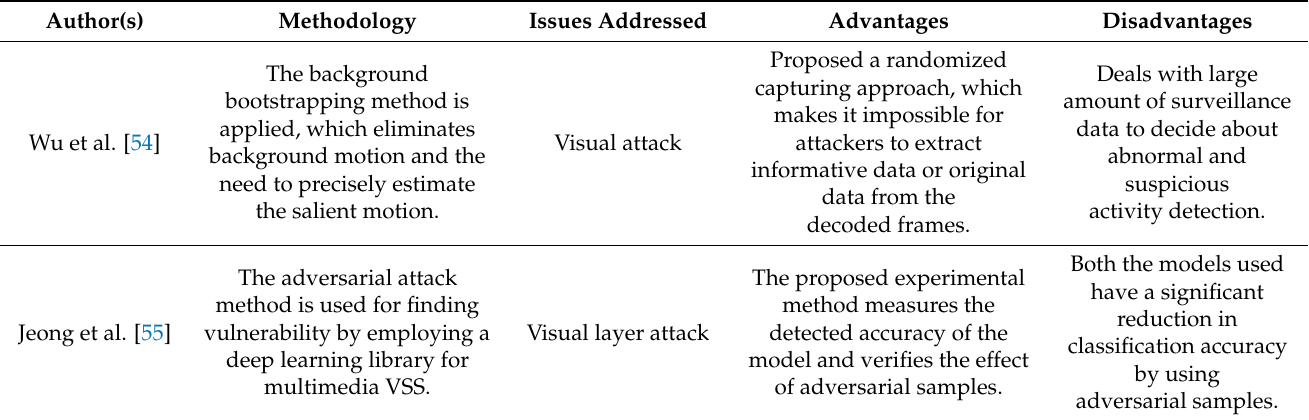
Table 4. Summary of literature review on VSS security and optimization